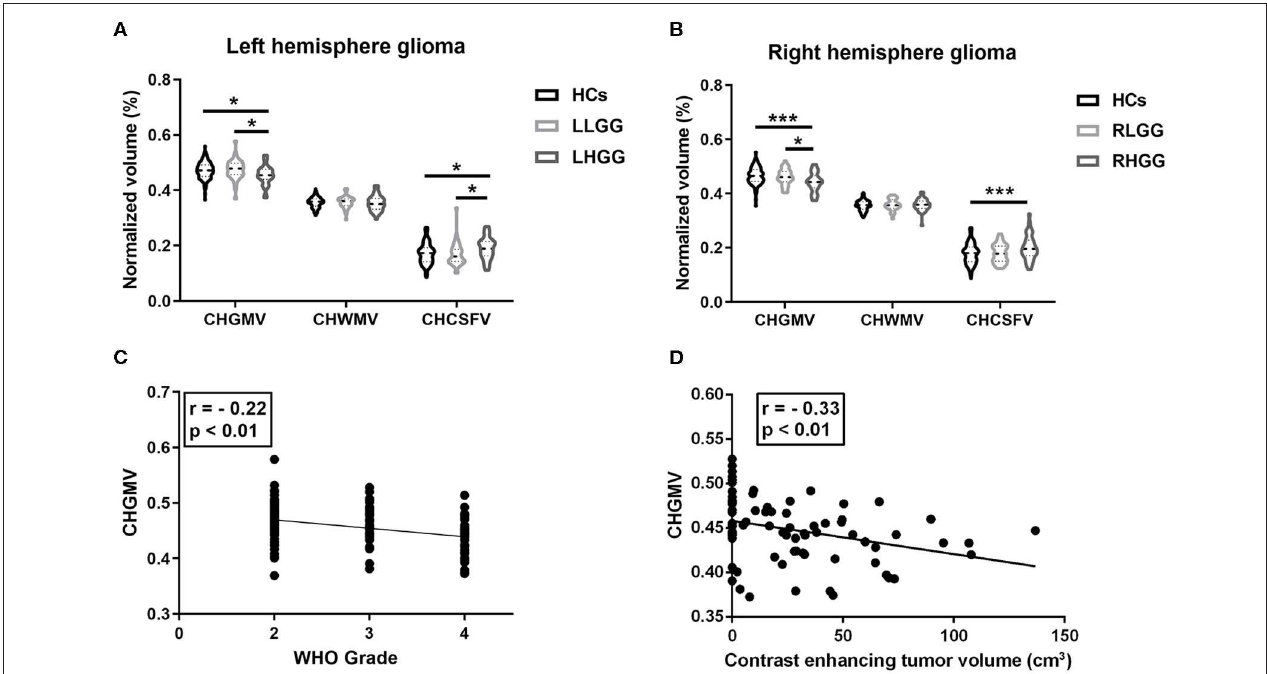
FIGURE 2 | Brain structure alteration in the patients with gliomas. (A) In left hemisphere glioma, alterations of contra-hemispheric GM volume (CHGMV), WM volume (CHWMV), and CSF volume (CHCSFV) among LHGG group, LLGG group, and HCs (one-way ANOVA, Bonferroni corrected, * p < 0.05). (B) In right hemisphere glioma, alterations of CHGMV, CHWMV, and CHCSFV among RHGG group, RLGG group, and HCs (one-way ANOVA, Bonferroni corrected, * p < 0.05, *** p < 0.001). (C) Partial correlation analysis correcting for age between glioma grade and CHGMV in the patients. (D) In patients with high-grade gliomas, partial correlation analysis correcting for age between CHGMV and contrast enhanced